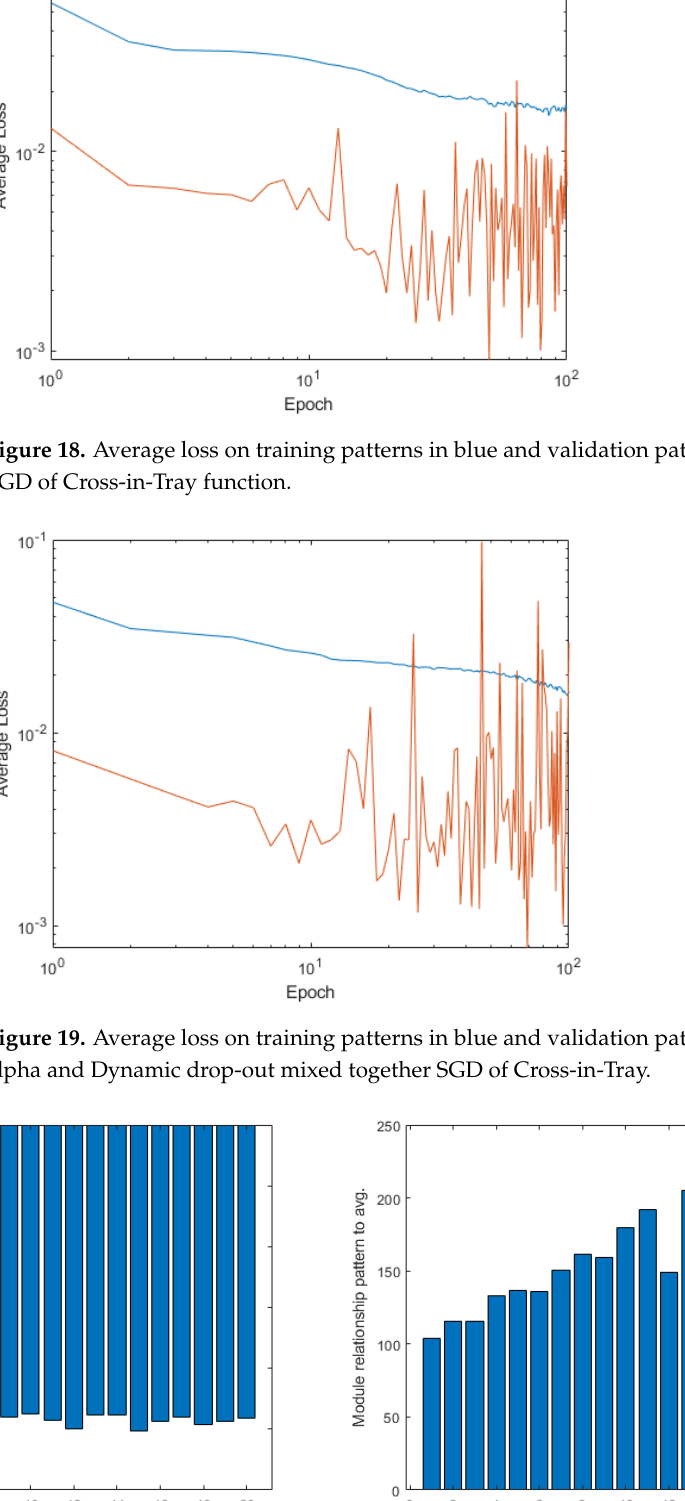
Figure 20. Unified worst learned patterns cos(φ) on the ( left ) and |